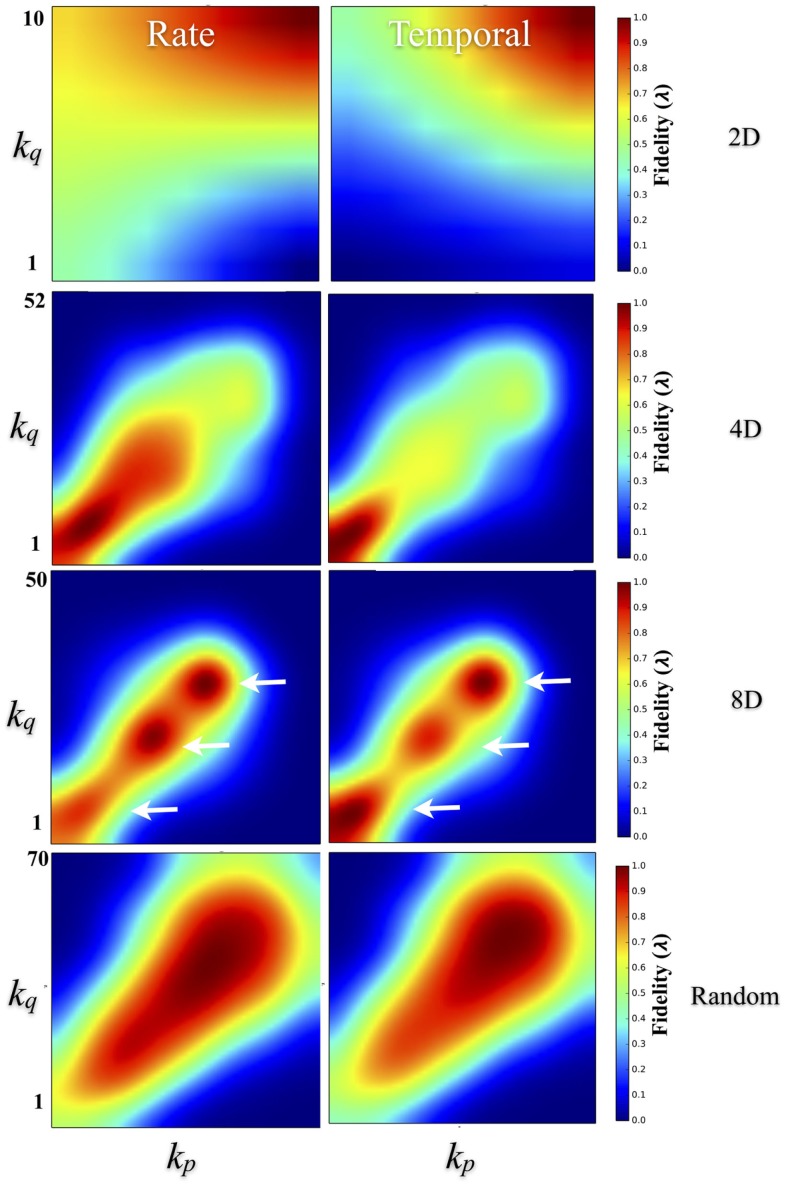
Degree–degree correlations effect transmission fidelity. Transmission fidelity is plotted relative to the values of the node’s degree between each communicating pair (i.e., the fidelity from nodes with degree ksource to ktarget) in the 2D, 4D, 8D, and Random network topologies. Fidelity is separated into rate (left column) and temporal-based scales (right column). The color scale represents fidelity from low: blue, to high: red. In the 4D, 8D, and Random networks transmission fidelity was highest during communication between nodes with similar node degrees as evidenced by the enhanced values along the diagonal. There were also non-linearities visible in the 8D and less so in 4D networks that appear as peaks (indicated with arrows) along the diagonal that occur in regions associated with node degree and fidelity observed earlier in Figures 7E,F. (Color scales are normalized within each panel from 0 to 1.0).